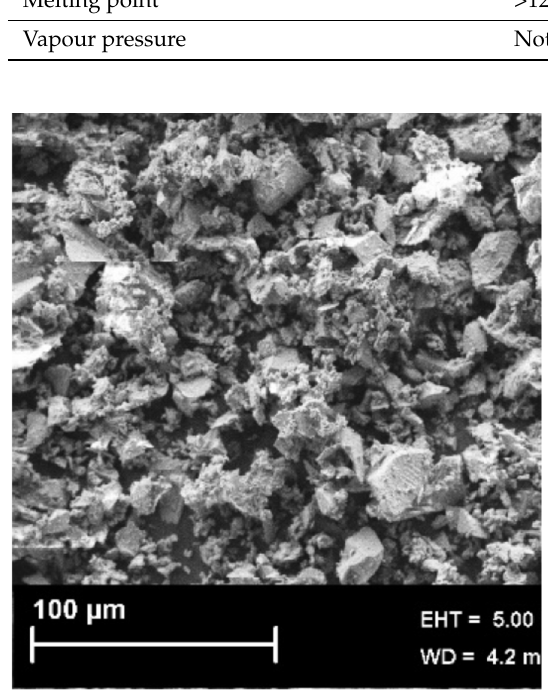
Figure 2. SEM image of the GGBFS used in the study.